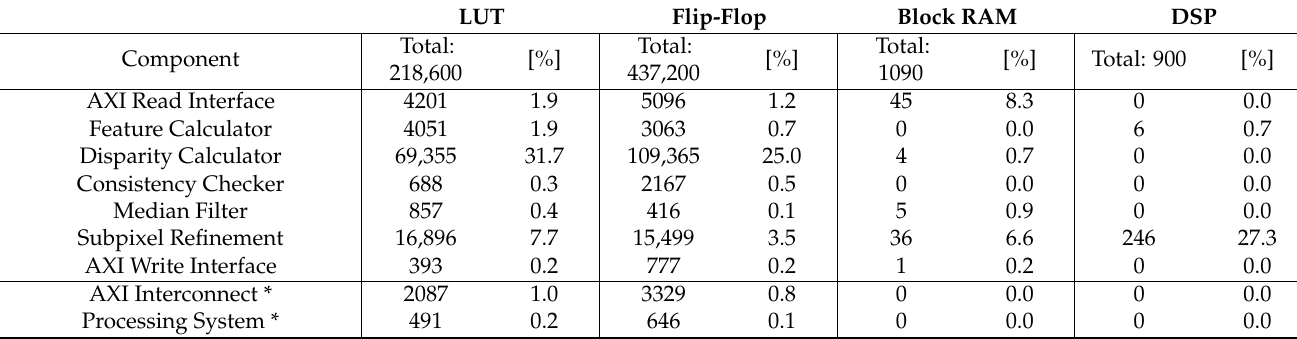
Figure 10. Resource utilization of individual FPGA primitives for the configuration N = 10.